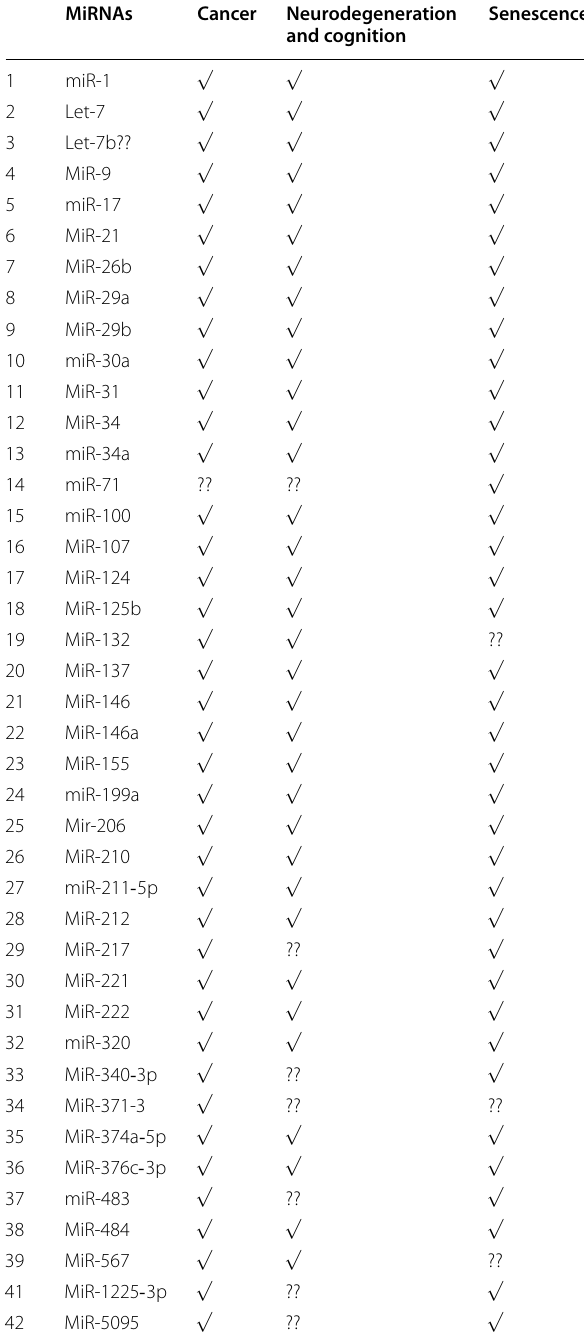
Table 1 Showing the correlation of miRNAs with cancer, cognitive function and